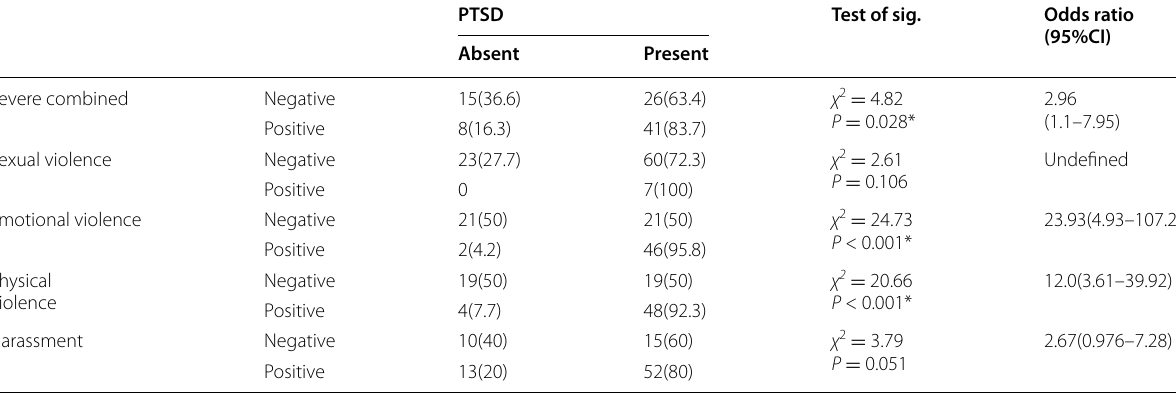
Table 5 Univariate analysis of post-traumatic disorders and types of violence among studied females